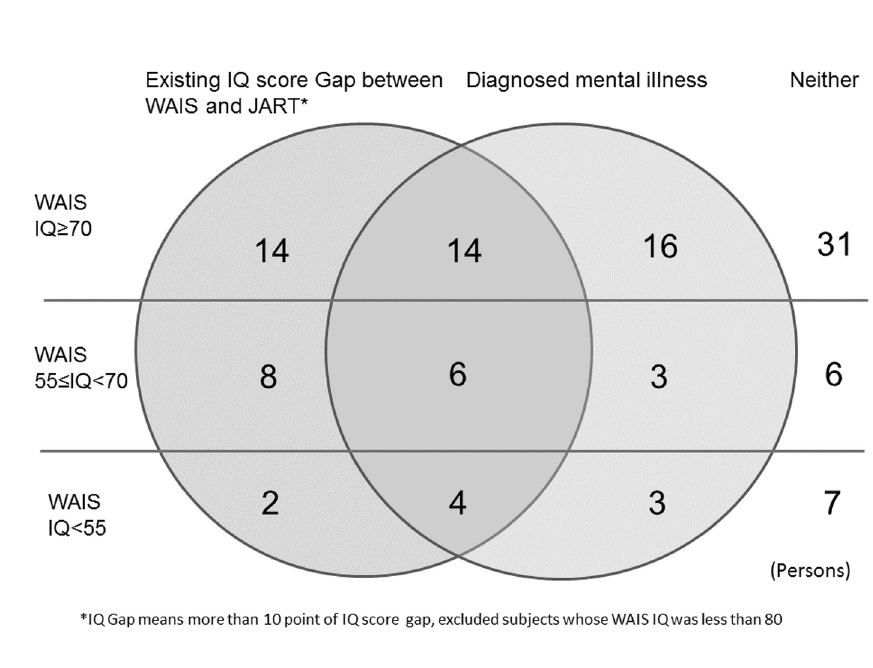
Table 3. Socio-demographic variables across the four participant groups. Mean age ± SD